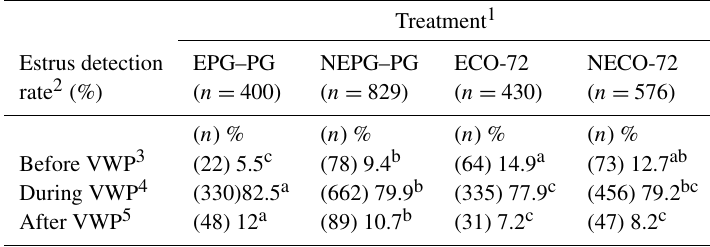
Table 1. Estrus detection rate for the four treatments according to the voluntary waiting period